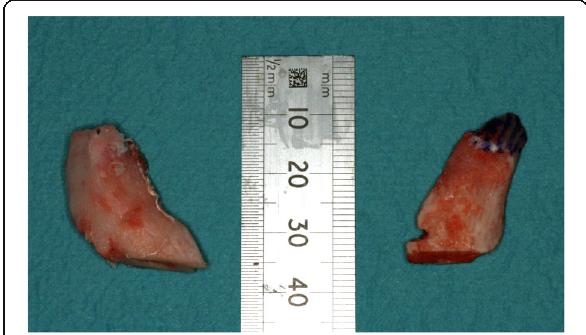
Fig. 11 Surgically removed coronoid processes